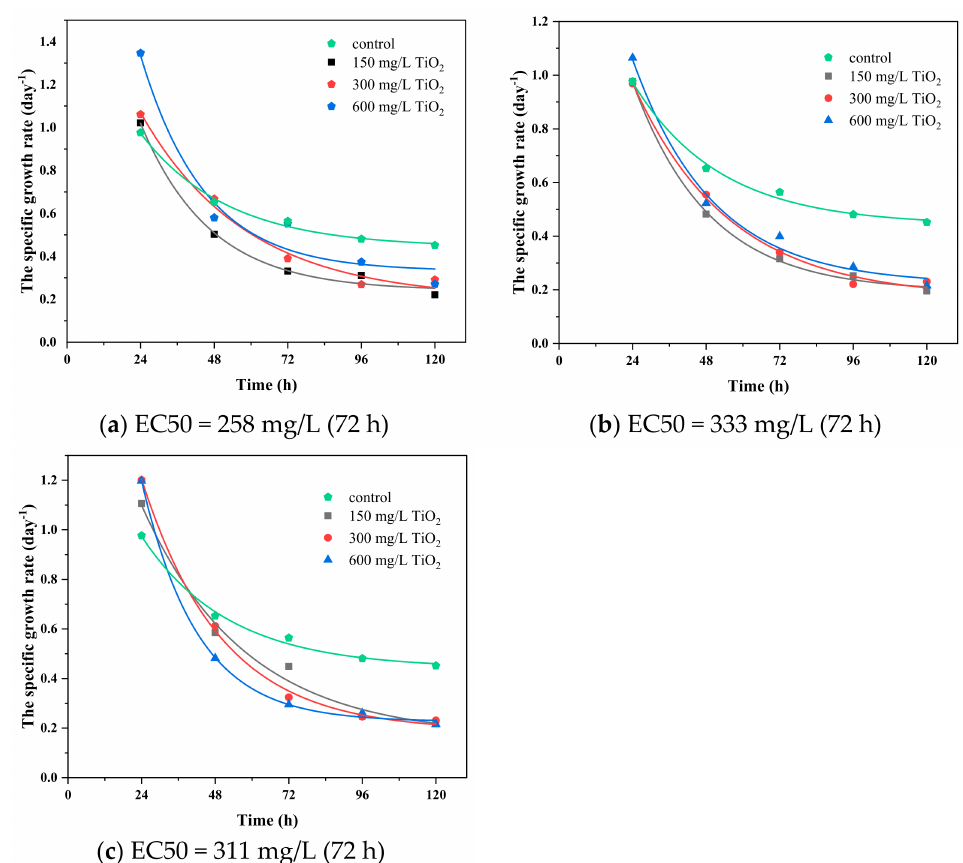
Figure 8. Growth curves of Chlorella vulgaris with different concentrations of TiO 2 (150, 300, and 600 mg/L) when IMD had a constant value 5 mg/L ( a ), 10 mg/L ( b ), and 20 mg/L ( c